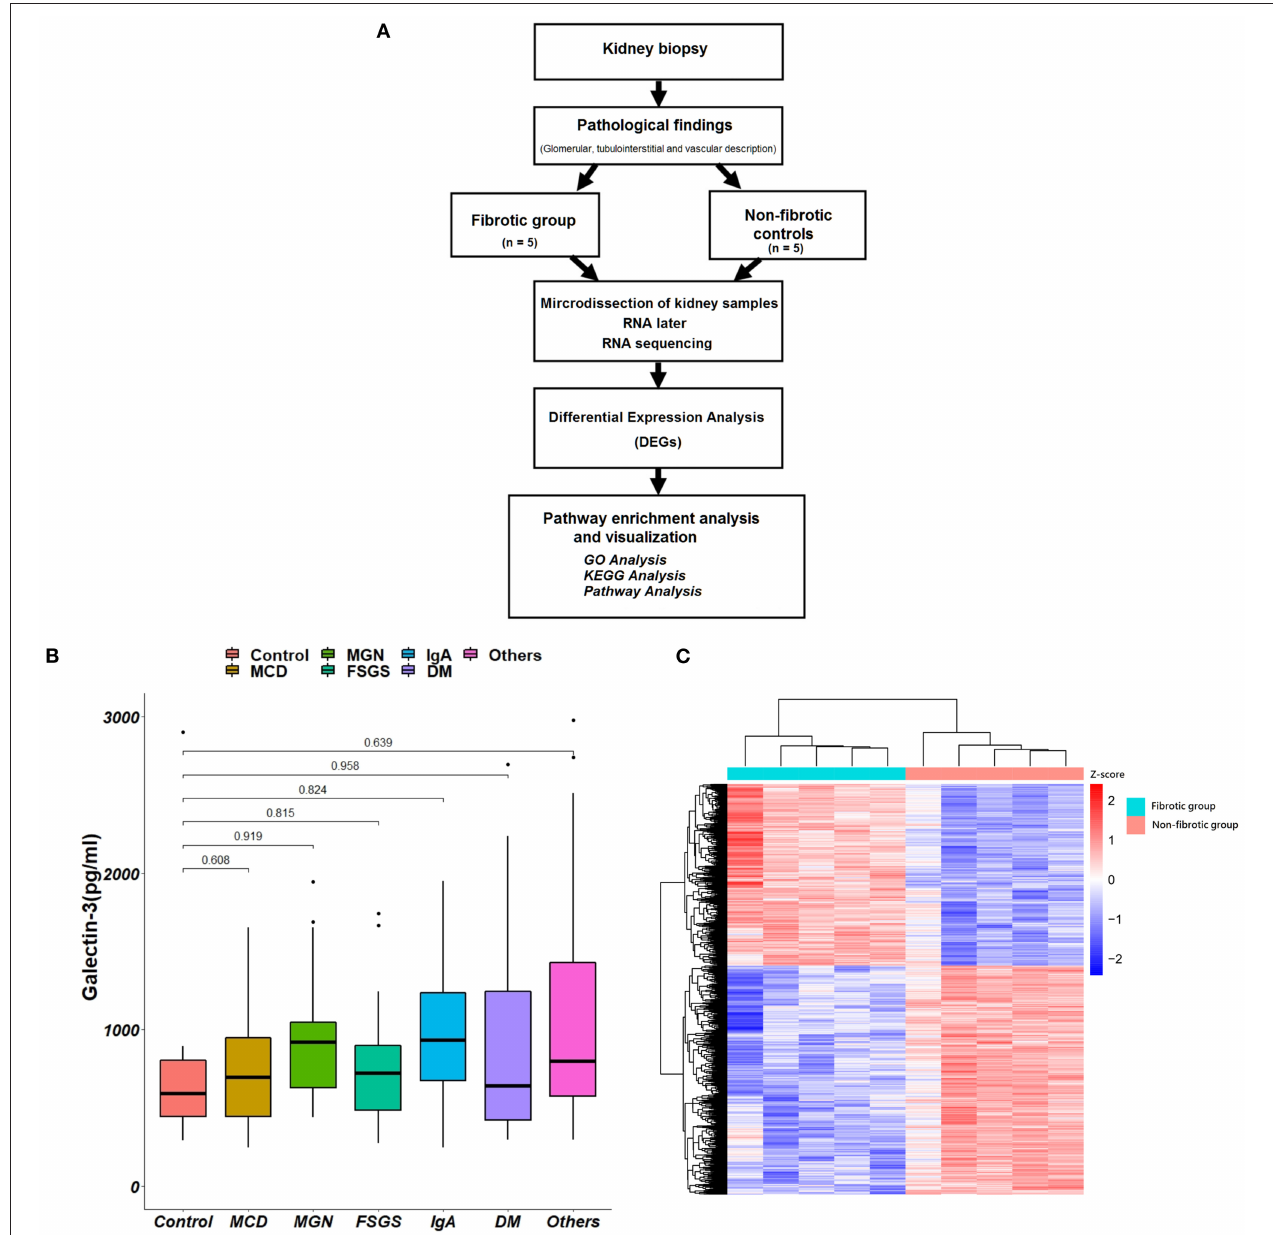
FIGURE 3 | Kidney biopsy specimens for pathology and RNA sequencing analysis. (A) The algorithm of the collections of kidney biopsy specimens. (B) The associations between different pathological diagnoses and plasma Gal-3 levels. (C) The hierarchical clustering heat map shows the expression of different genes between fibrotic groups and non-fibrotic controls. Gal-3, galectin-3; GO, Gene Ontology; KEGG, Kyoto Encyclopedia of Genes and Genomes; MCD, minimal change disease; FSGS, focal segmental glomerulosclerosis; IgA, immunoglobulin A; DM, diabetes mellitus.